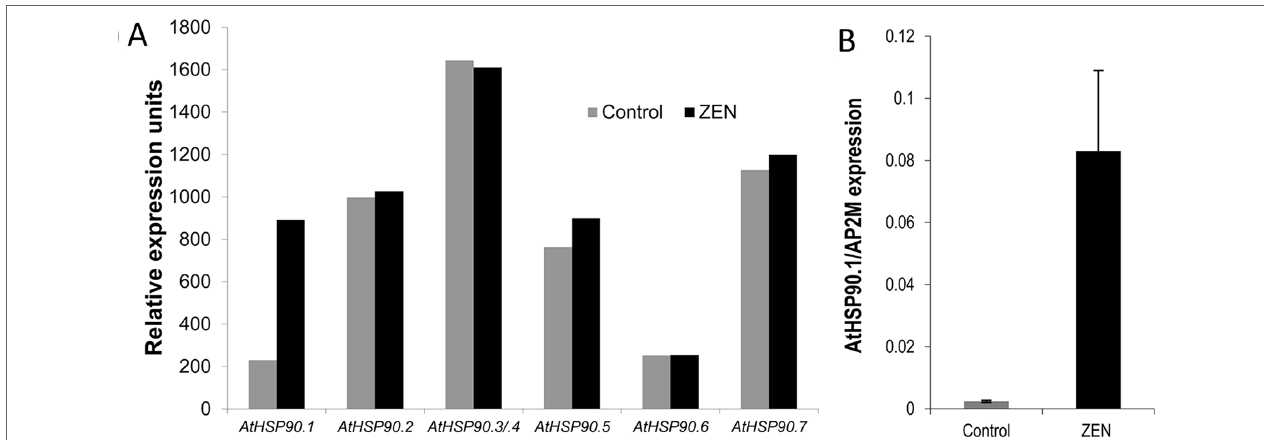
FIGURE 2 | Transcriptional response of Arabidopsis thaliana HSP 90 genes to zearalenone (ZEN). (A) Expression levels of A. thaliana HSP 90 genes after 2 h treatment with ZEN (50 µM) or solvent (control; dimethyl sulfoxide, DMSO) according to microarray data from Werner (2005). The genes HSP90.3 and HSP90.4 cannot be distinguished by the probes on the chip (labeled HSP90.3/4 ). (B) Quantitative real-time PCR of A. thaliana HSP90.1 after 2 h treatment with ZEN (50 µM) or DMSO. The results are expressed as relative expression to the reference gene ADAPTOR PROTEIN-2 MU-ADAPTIN ( AP2M; AT5G46630 ) and represent the means of four biological replicates ± standard